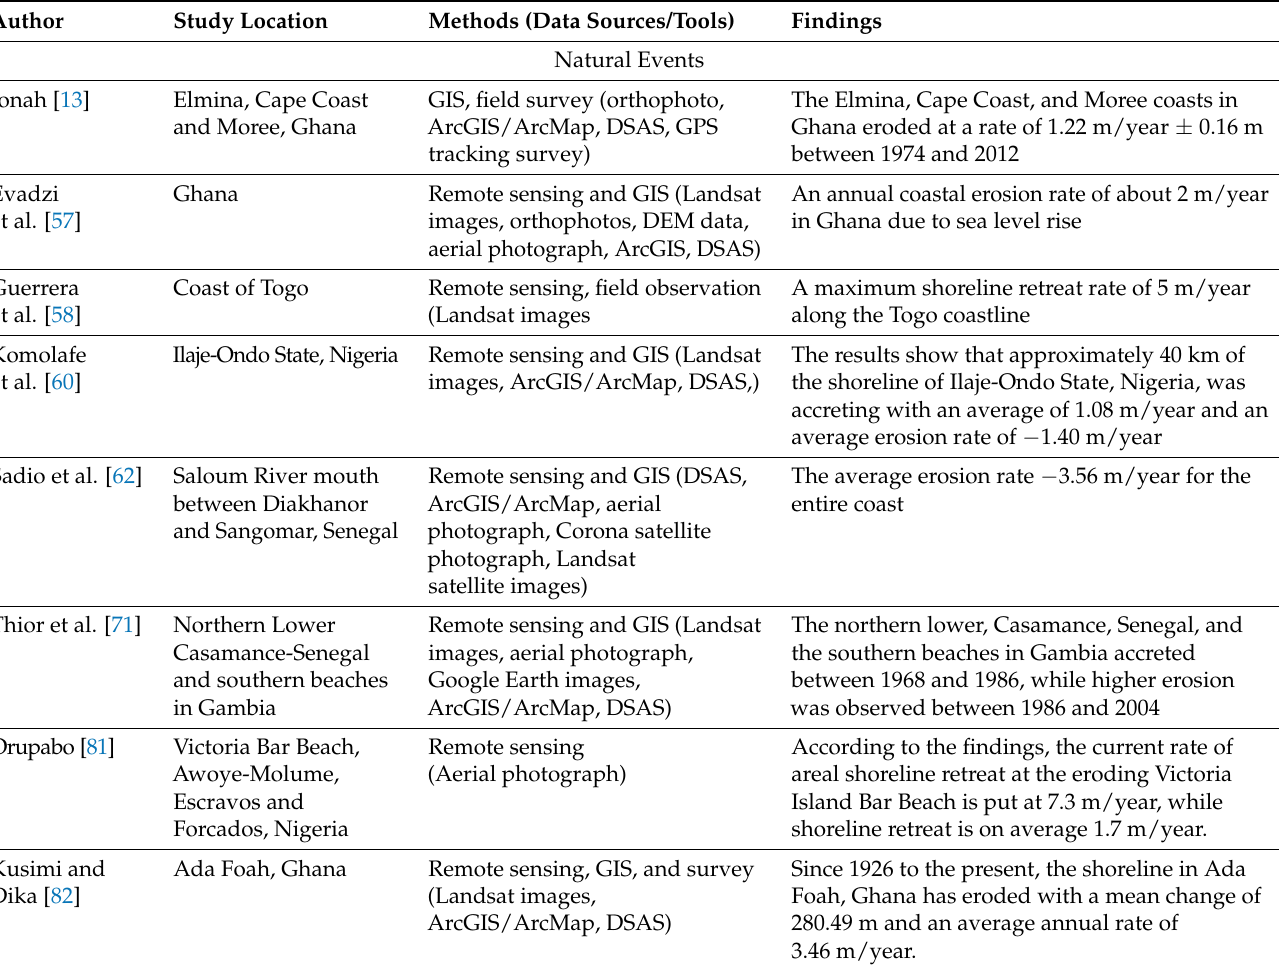
Table 2. A summary of shoreline change and coastal erosion caused by natural events and human